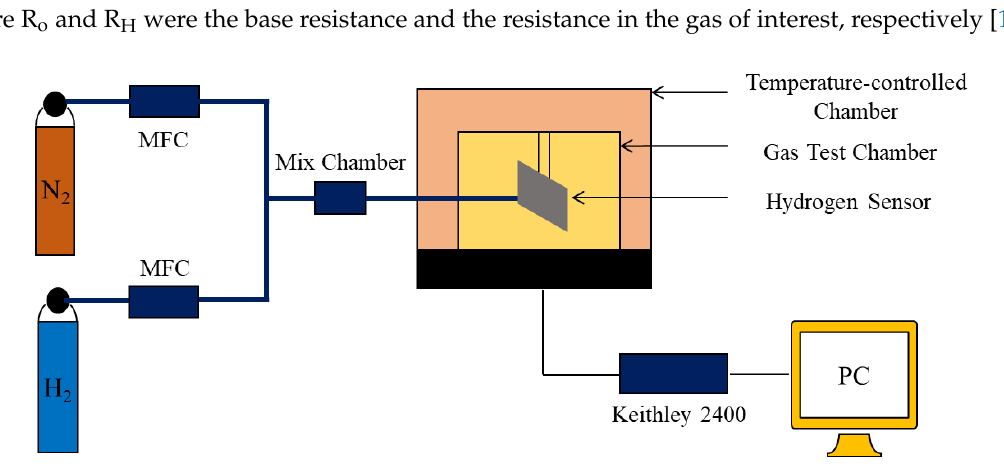
Figure 3. Schematic of the hydrogen measuring system.